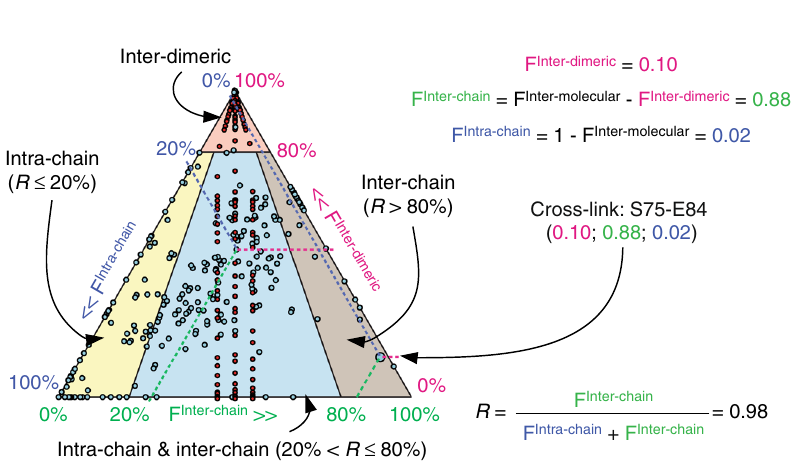
Fig. 4 Mapping lamin A inter-dimeric, inter-chain and intra-chain residue interactions. Frequencies of occurrence as inter-dimeric F Inter-dimeric (magenta axis), intra-dimeric inter-chain F Inter-chain (green axis) or intra-chain F Intra-chain (blue axis) calculated as shown (see also Supplementary Data 4) and plotted on a triangle plot for each cross-link in bands 1 – 3 and band 4 (see also Supplementary Table 1). Band 4 was analysed only in the HIDm experiment, therefore for only the F Inter-dimeric for these cross-links. Cross-links were deemed as predominantly ( F > 80%) inter-dimeric (red sector), as intra- dimeric&intra-chain if R ≤ 20% (yellow sector), intra-dimeric&inter-chain ( R > 80%, beige sector), intra-dimeric and both intra-&inter-chain (20% < R ≤ 80%, light-blue